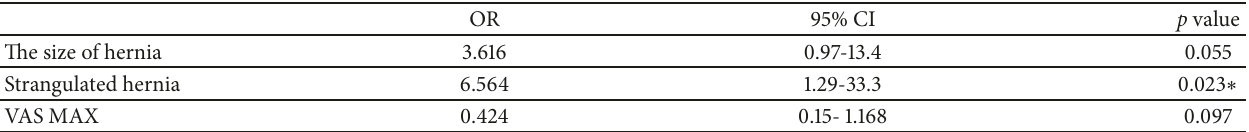
Table 5: Risk factors (Odds Ratio, 95% confidence interval, and p value) for the seroma formation after laparoscopic transabdominal preperitoneal